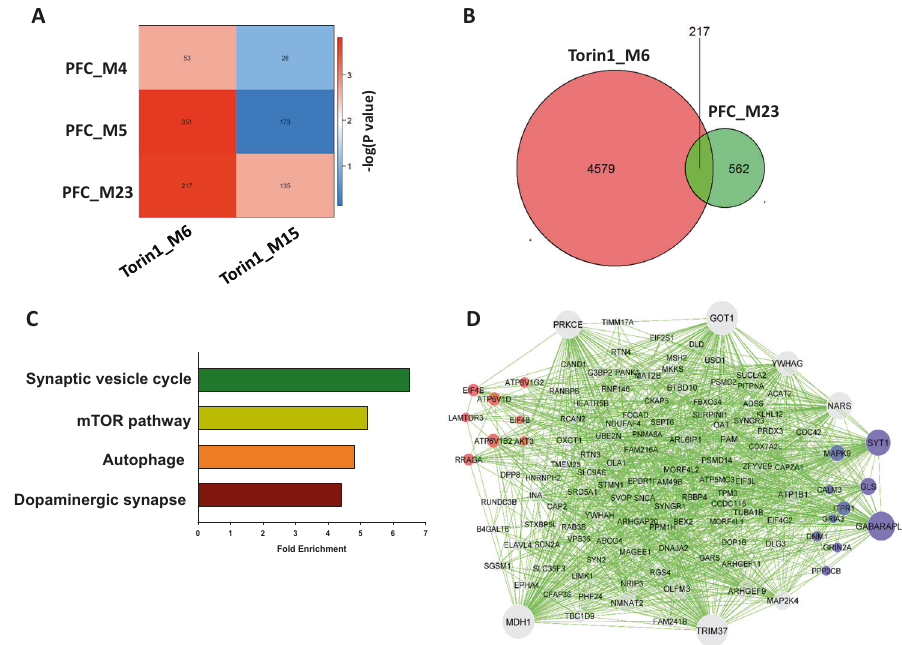
Fig. 4 Comparison of the differentially expressed modules in the PFC of BPD to those from Torin1 treated neurons. Pairwise comparisons of the modules differentially expressed in BPD and the differentially expressed modules in Torin1-treated neurons ( A ). The color code of the heatmap encodes − log ( P -value). The P -values were calculated by permutation test for the overlap of the two modules. The numbers in the heatmap indicate gene counts in the intersection of two modules. Venn diagram shows the number of common and unique genes between the PFC_M23 and the Torin1_M6 module ( B ). KEGG pathways signi fi cantly enriched in the genes common to both co-expression modules ( C ) and visualization of the network connections of the common genes between the two modules using Cytoscape [25] ( D ). The hub genes are larger